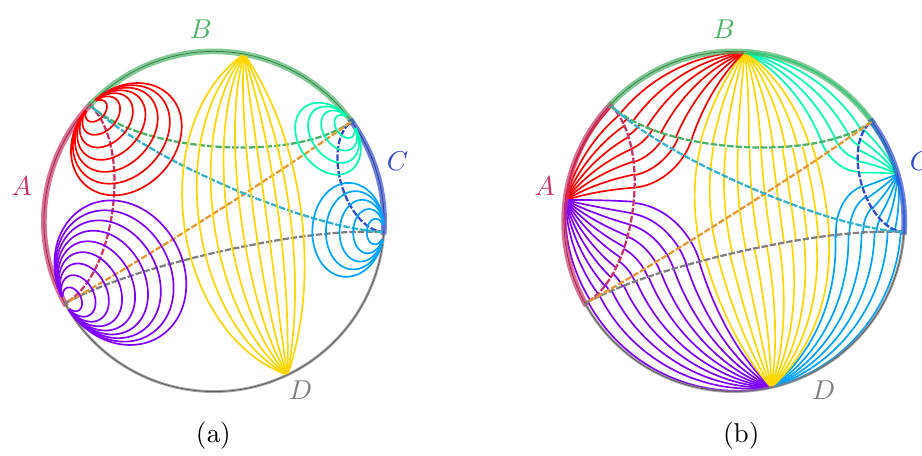
Figure 4 . Illustration of two distinct constructions for obtaining combed maximizer (cid:13)ows using foliations. (a) smooth (cid:13)ows obtained by 5 superimposed foliations. (b) patched (cid:13)ows obtained by a single bulk ‘local foliation’. The boundary regions and associated minimal surfaces are as in (cid:12)gure 1, and the threads are indicated by solid curves, with distinct colors delineating the regions a; b; c; d; e of (cid:12)gure 2 which contain the corresponding thread